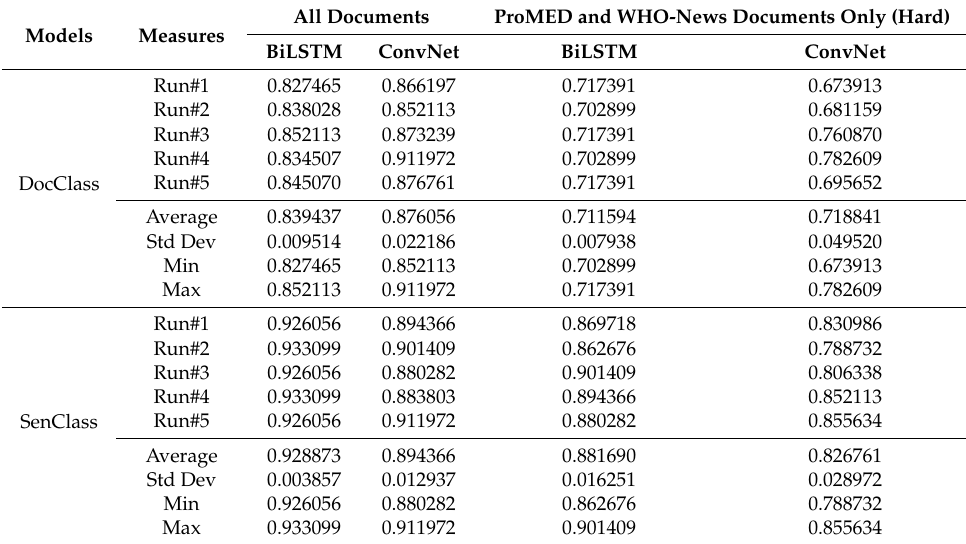
Table 4. The accuracy of the deep learning models for detecting infectious disease